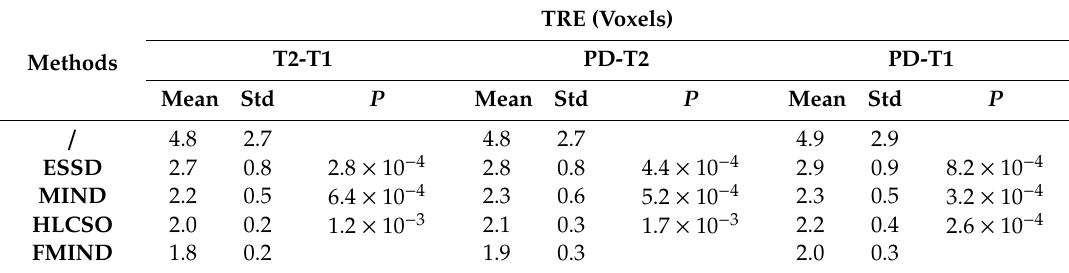
Table 1. The TRE for all evaluated methods and the P values for the t -test between the FMIND method and other compared methods operating on the T2-T1, PD-T2, and PD-T1 image pairs.